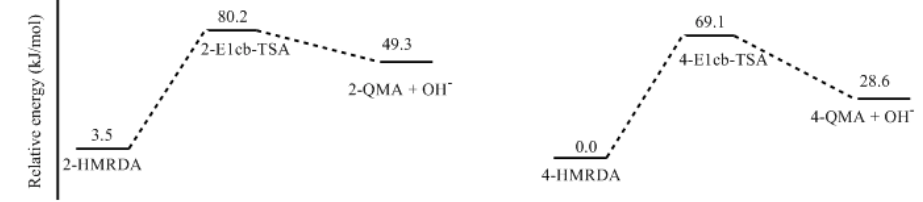
Figure 9. The potential energy profiles for the E1cb formation of quinonemethide anions (QMAa).